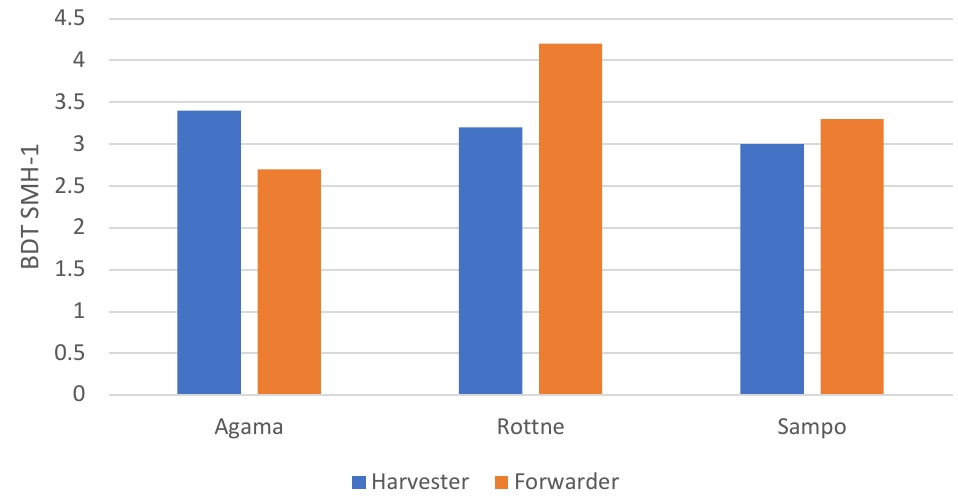
Figure 5. Harvester and forwarder productivity juxtaposed for the three chains using the same thinning forwarder (Sampo FR28).